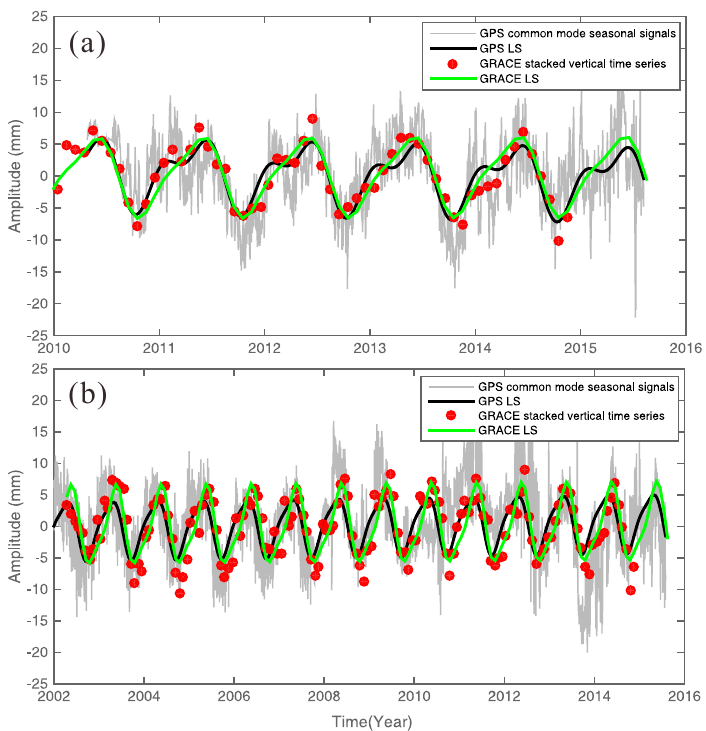
Figure 5. The first common mode from the EOF corresponding to the seasonal signals based on ( a ) the records from 2010 to 2015 of 38 GPS stations, and ( b ) the three CGPS sites records are from 1999 to 2015. In order to compare with GRACE data (data records from 2002 to 2015), we just selected GPS data from 2002 to 2015. GRACE monthly measurements span from April 2002 to November 2014. Gray lines (daily solutions) and red dots (monthly solutions) correspond to the GPS and GRACE results, which are LS fitted by the expression in Equation (2) (i.e., the black and green lines, respectively).